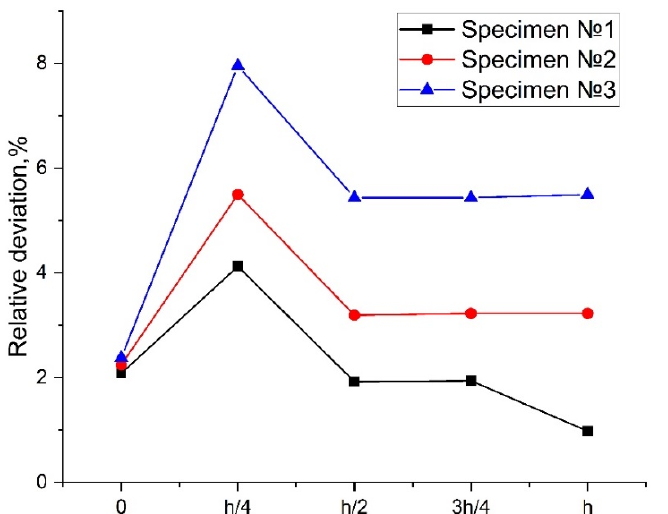
Figure 12. Dependencies of relative deviation of the hardness values along the height of the speci-